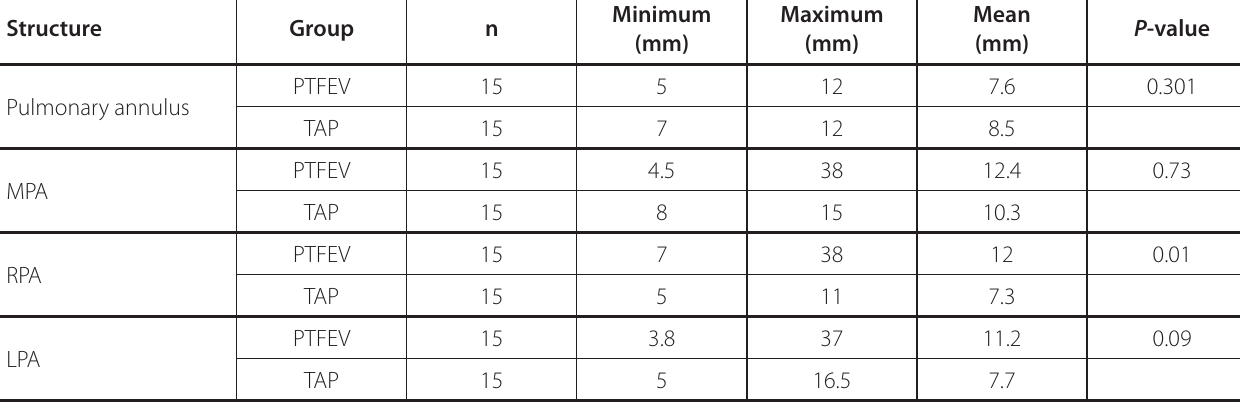
Table 3 . Preoperative pulmonary artery dimensions based on cardiac catheterization study. Structure